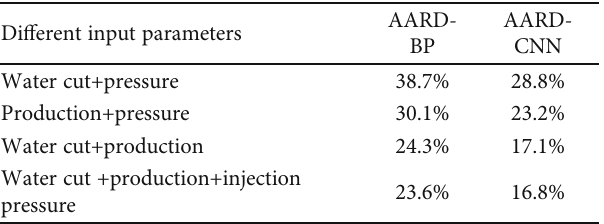
Table 7: The e ff ects of di ff erent input parameters on the predicted result.